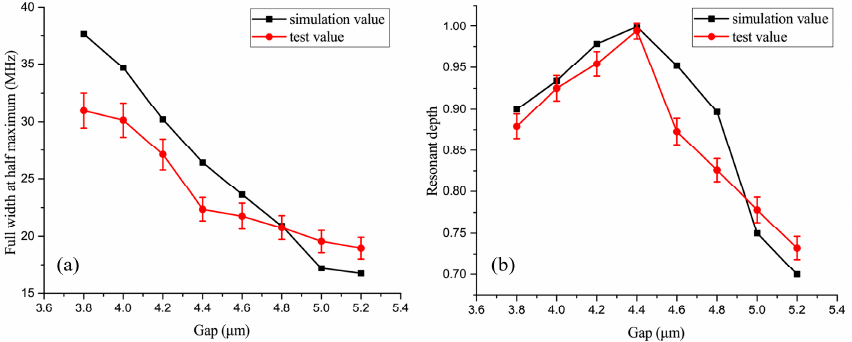
Figure 5. ( a ) Comparison of measured and simulated FWHM values for different gaps; ( b ) Comparison of measured and simulated resonant depth values for different gaps.